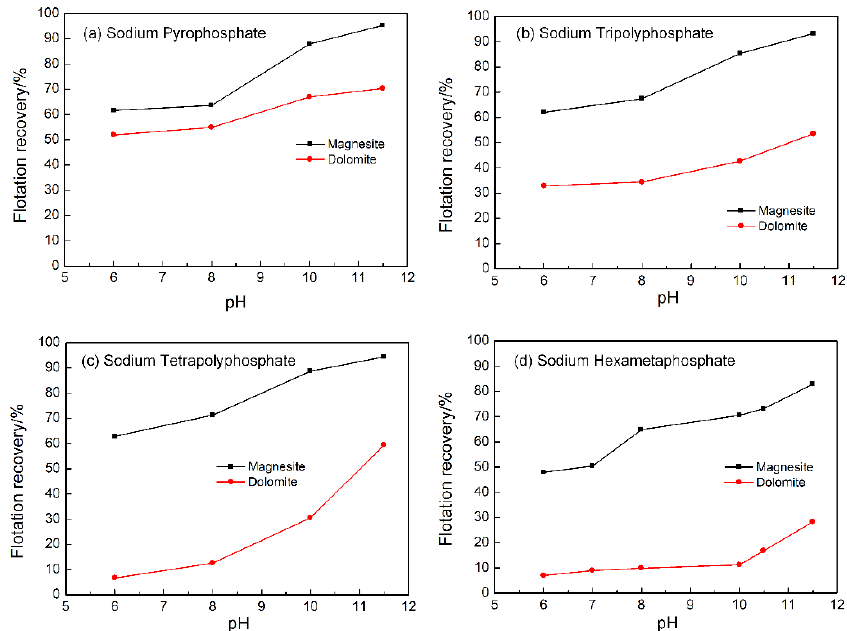
Figure 6. The e ff ect of pH on mineral flotation recovery with di ff erent depressants. Sodium Oleate Figure 6. The effect of pH on mineral flotation recovery with different depressants. Sodium Oleate 3 3 × 10 − 4 mol / L.( a )SodiumPyrophosphate300mg / L,( b )SodiumTripolyphosphate200mg / L,( c )Sodium × 10 –4 mol/L. ( a ) Sodium Pyrophosphate 300 mg/L, ( b ) Sodium Tripolyphosphate 200 mg/L, ( c ) Tetrapolyphosphate 100 mg / L, ( d ) Sodium Hexametaphosphate 4 mg /